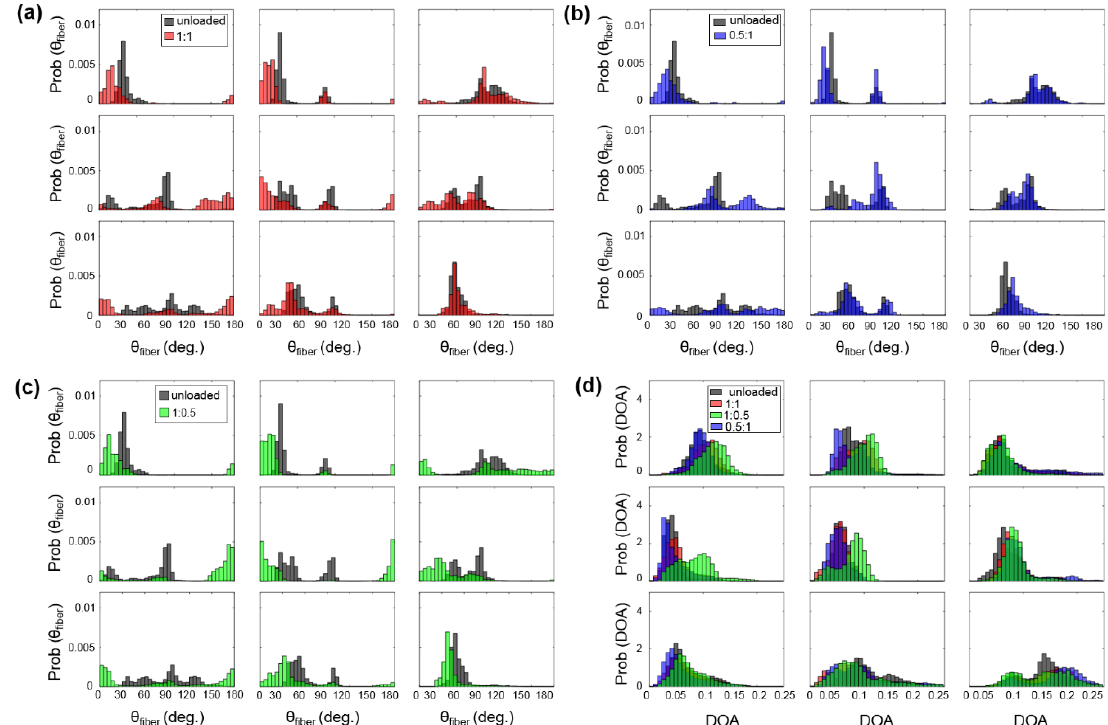
Figure A2. 3 × 3 grid comparisons of the predicted θ fiber : ( a ) between unloaded and equibiaxial loading, ( b ) between unloaded and radially-dominate loading, and ( c ) between unloaded and circumferentially-dominate loading. ( d ) Comparison of the predicted DOA among all the states for the TVAL specimen of heart #1.